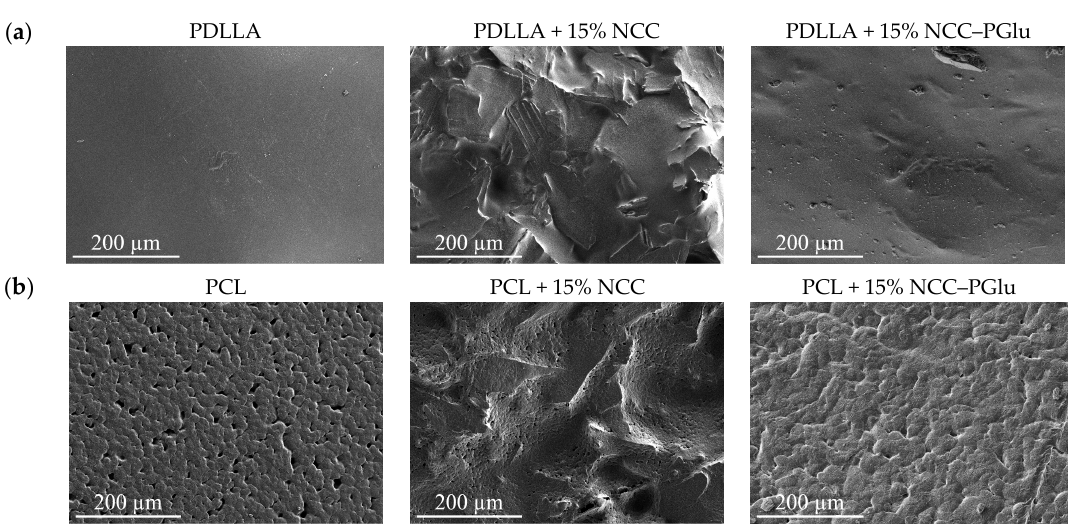
Figure 3. SEM images of PDLLA-based ( a ) and PCL-based ( b ) pure and composite films (500 × ).